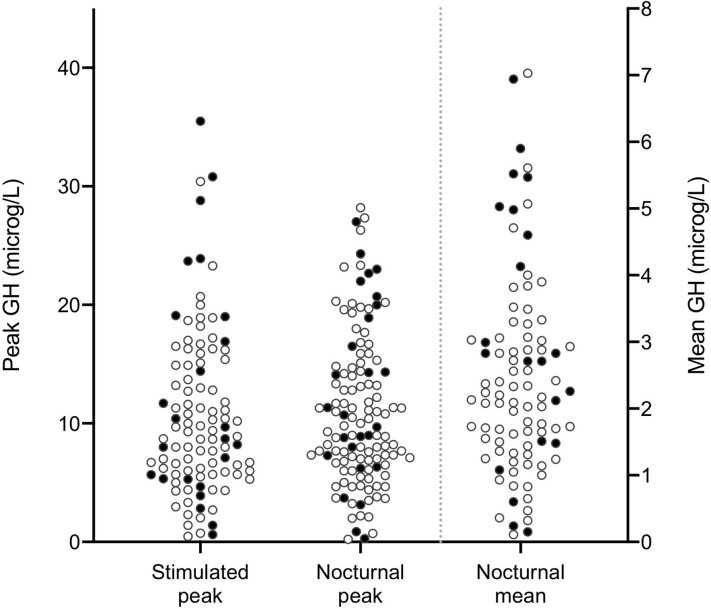
Scatter plots of maximum peak stimulated (AITT) and nocturnal spontaneous GH values and nocturnal mean values (µg/L) in 123 children with short stature evaluated for possible GHD. AITT, arginine-insulin tolerance test. GH, growth hormone. GHD, growth hormone deficiency. Open circles represent prepubertal patients and filled circles represent pubertal or primed patients.